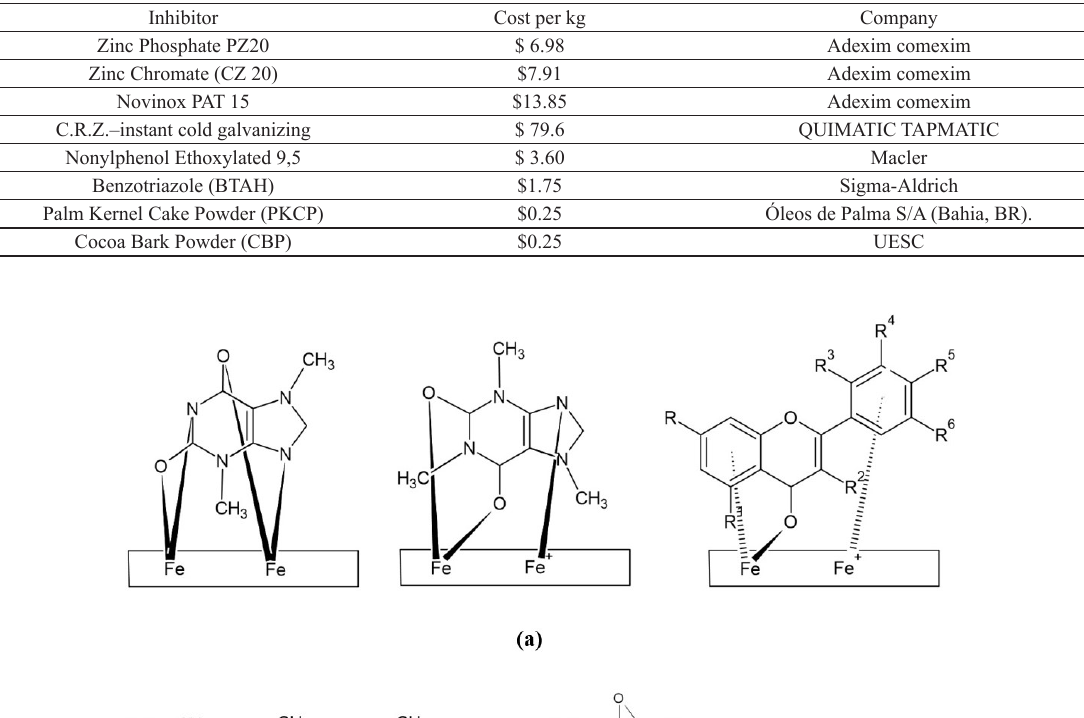
Table 4. Cost of market values for the main synthetic inhibitors.